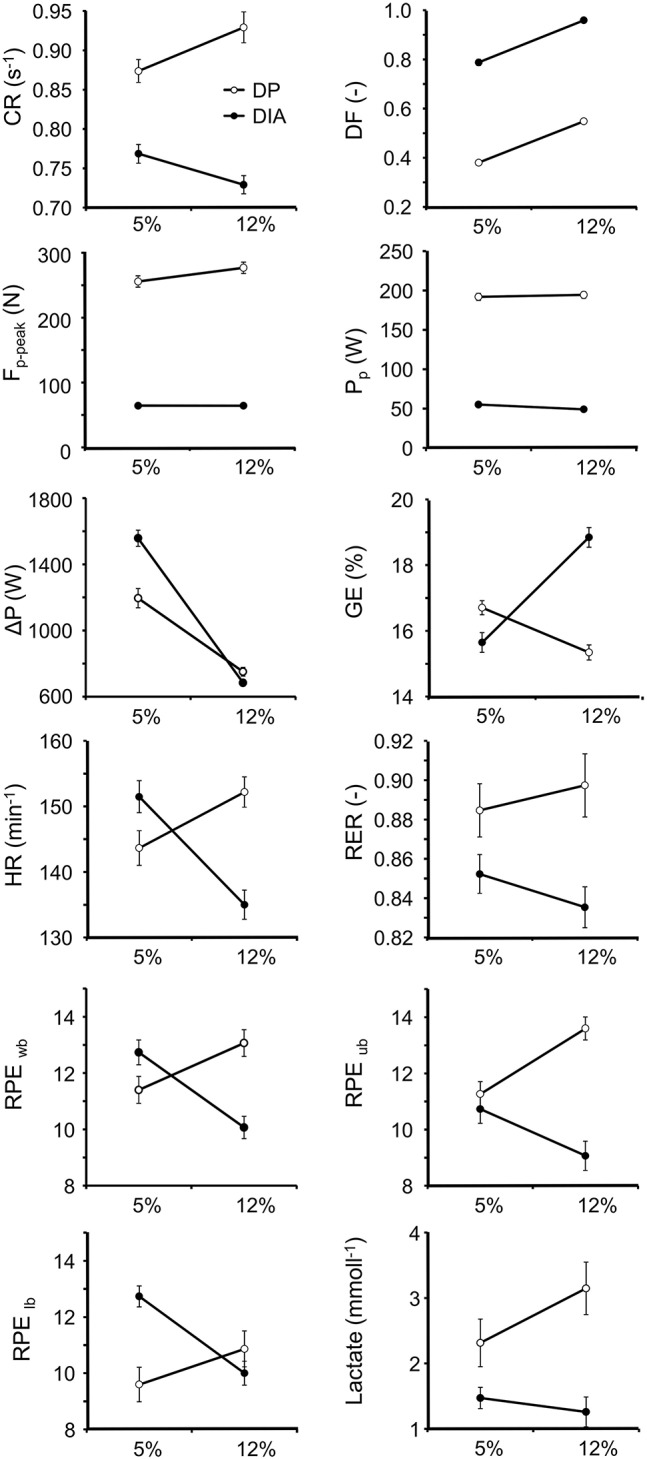
Comparison of kinetics, physiological responses, and perceived load (mean and s.e.m., N = 15) in DIA and DP in two incline-speed conditions at 200 W workload while roller skiing. The statistical outcome of the comparisons is given in Table 1. CR, cycle rate; DF, duty factor (fraction of cycle time); Fp−peak, peak pole force; Pp, pole power; ΔP, power fluctuation. GE, gross efficiency; HR, heart rate; RER, respiratory exchange ratio; RPE, rate of perceived exertion; wb, whole body; ub, upper body; lb, lower body.